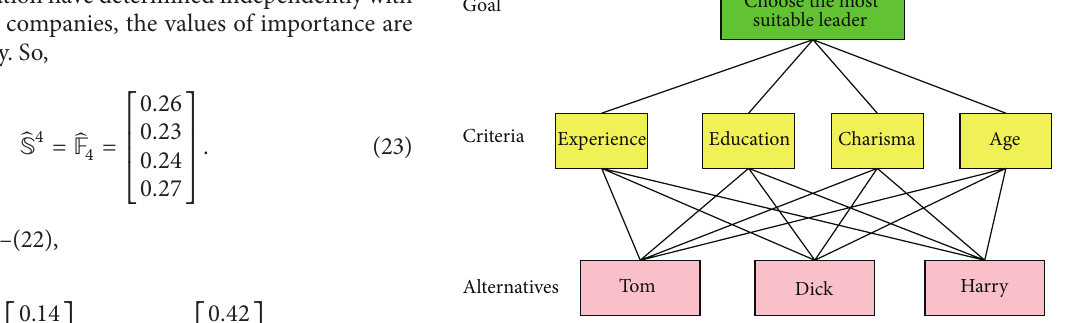
Figure 1: Decision